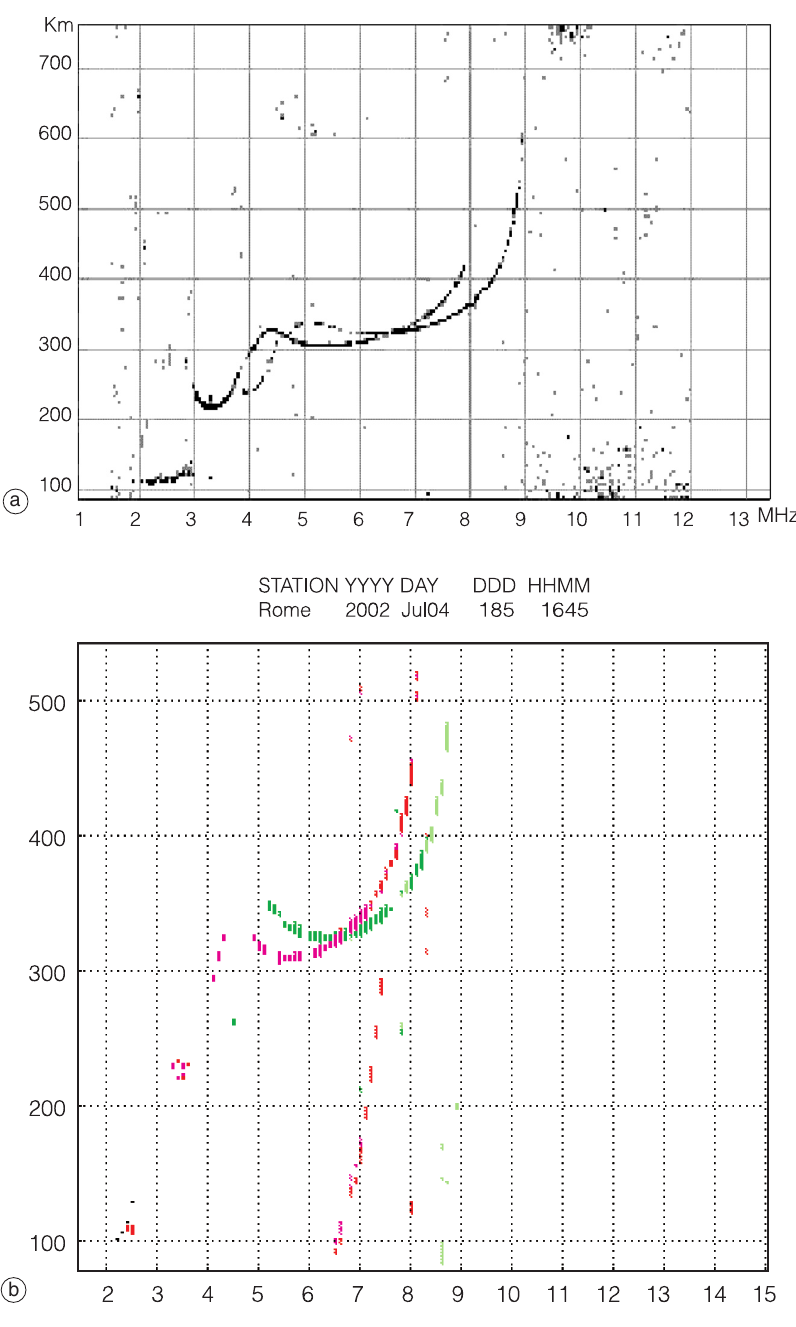
Fig. 5a,b. Ionograms recorded at 5.45 p.m. 2002/5/29: a) AIS-INGV ionosonde; b) other digital